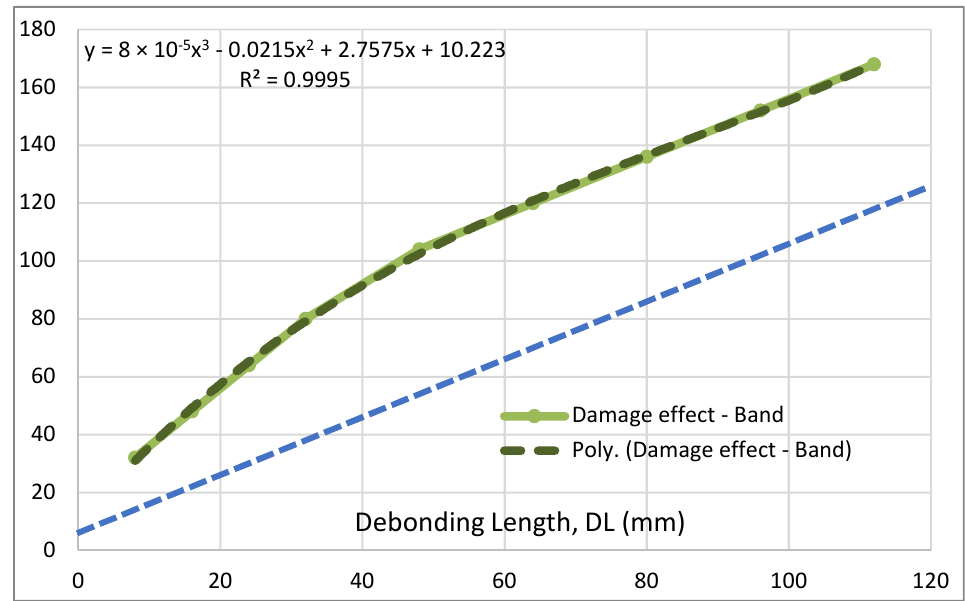
Figure 16. Damage effect width vs. actual debonding length; in blue, the reference linear link (1:1).